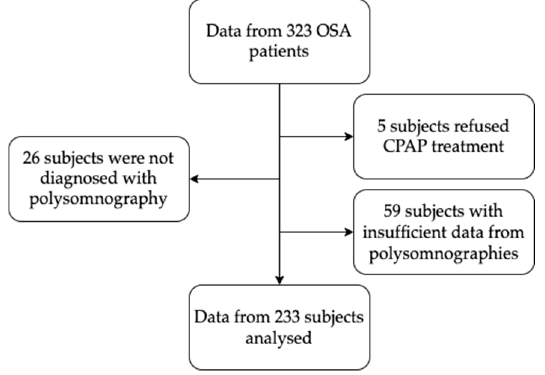
Figure 1. Selection of study subjects. Abbreviation: CPAP - continuous positive airway pressure, OSA–obstructive sleep apnea.